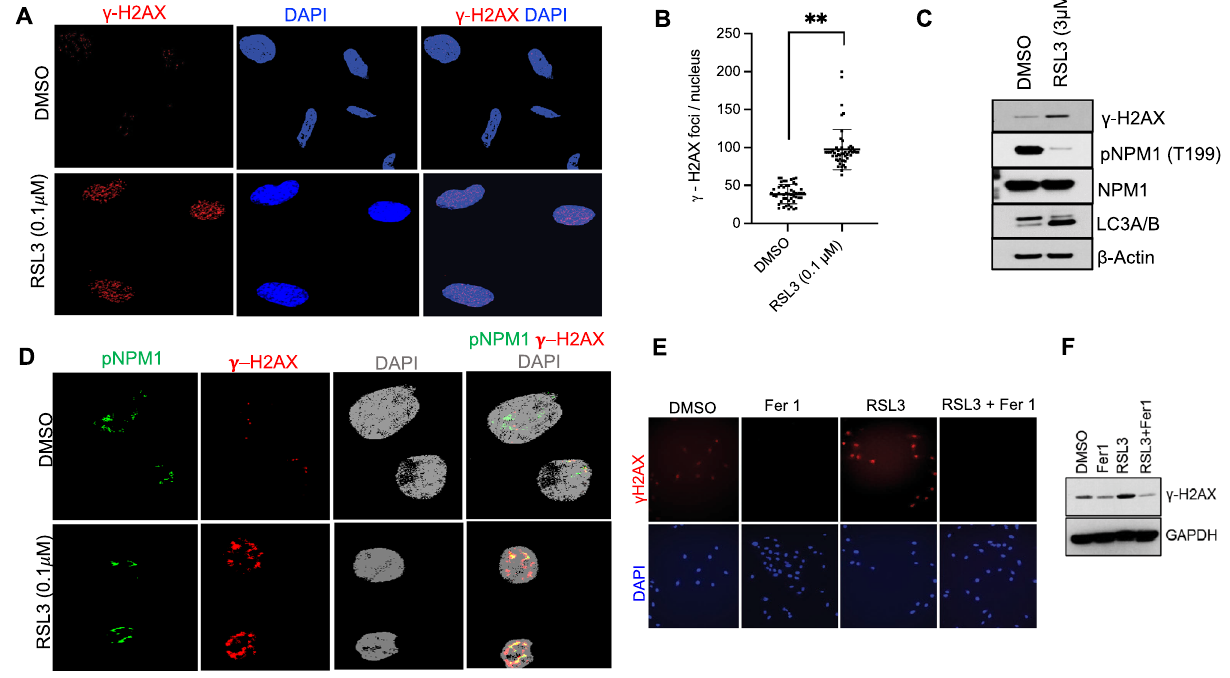
Figure 4. RSL3 induces double-stranded DNA breaks and inhibits DNA damage repair response in PTC in vitro. ( A ) Immunofluorescent staining for γ-H2AX nuclear foci expression in K1 cells treated with RSL3 or DMSO-control (γ-H2AX = red, DAPI = blue, × 20 magnification). ( B ) Quantification of γ-H2AX foci in 50 RSL3-treated K1 cells and 50 control-treated cells (RSL3, 97.3 foci/cell vs DMSO, 38.6 foci/cell; p < 0.0001). ( C ) Western blot analysis of γ-H2AX, pNPM1, NPM1, and LC3A/B in RSL3-treated or DMSO-treated K1 cells. ( D ) Dual immunofluorescent staining of K1 cells for pNPM1 (T199) and γ-H2AX co-localization using confocal microscopy (pNPM1 = green, γ-H2AX = red, DAPI = gray, × 63). ( E ) Immunofluorescent staining for γ-H2AX expression in RSL3-, Fer1- and DMSO-treated K1 cells (γ-H2AX = red, DAPI = blue, × 20 magnification). ( F ) Western blot analysis of γ-H2AX expression in RSL3-, Fer1- and DMSO-treated K1